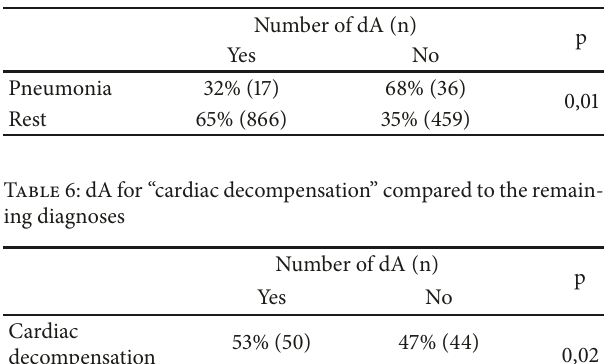
Cardiac decompensation